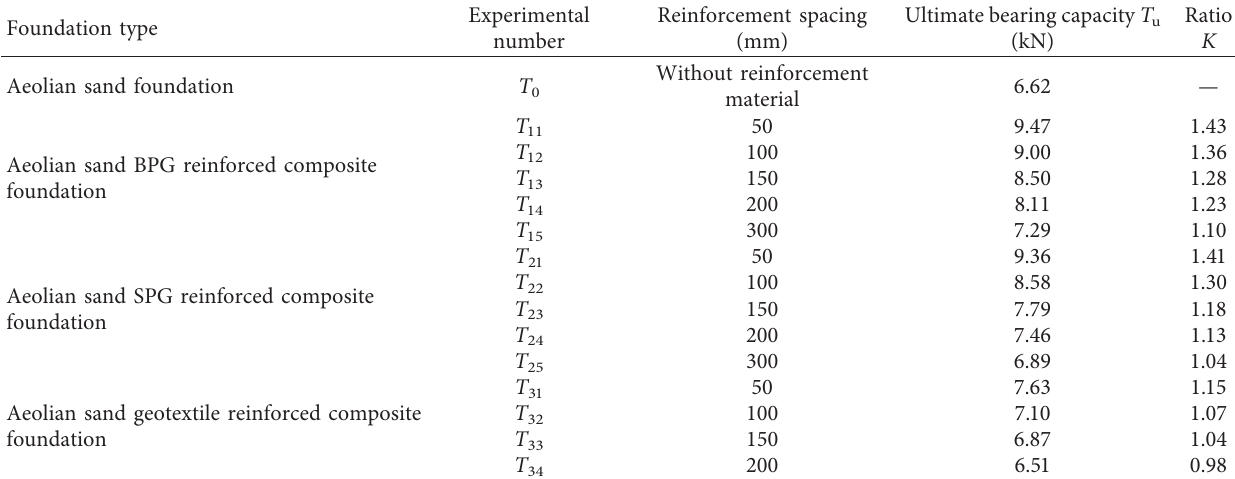
Table 3: Model test